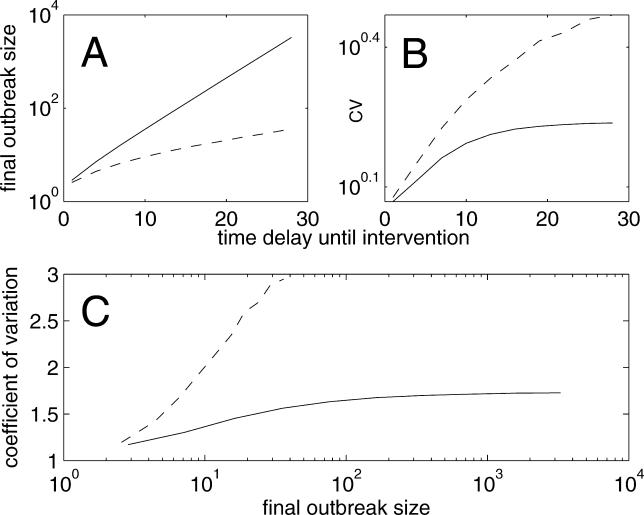
Effect of Time Delay until Intervention on Outbreak SizeEffect of time delay until intervention on outbreak size is contrasted for outbreaks with R
0 = 2 (solid lines) and R
0 ≍ 1.1 (dashed lines).(A) Average outbreak size (y-axis) increases with the number of days until intervention (x-axis).(B) CV in outbreak size (y-axis) increases with the number of days until intervention (x-axis).(C) CV in outbreak size (y-axis) increases at a declining rate (i.e., levels off) as the average outbreak size increases (x-axis). Note that the CV in final outbreak size increases faster in the outbreak with lower R
0.